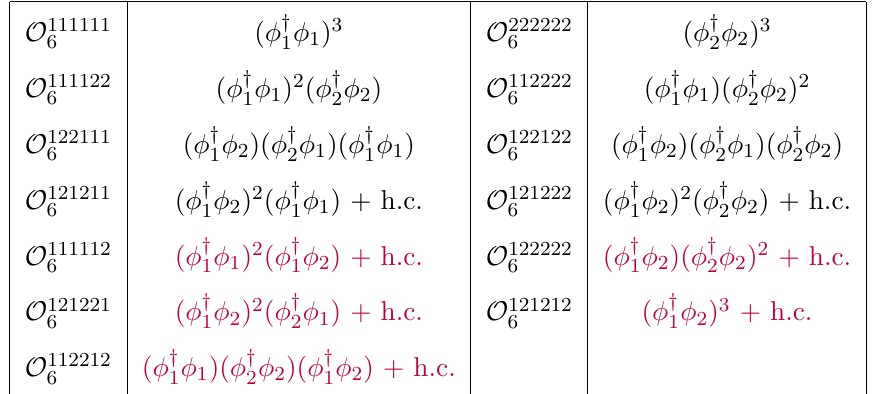
2 = 20] class of operators. (cid:2)